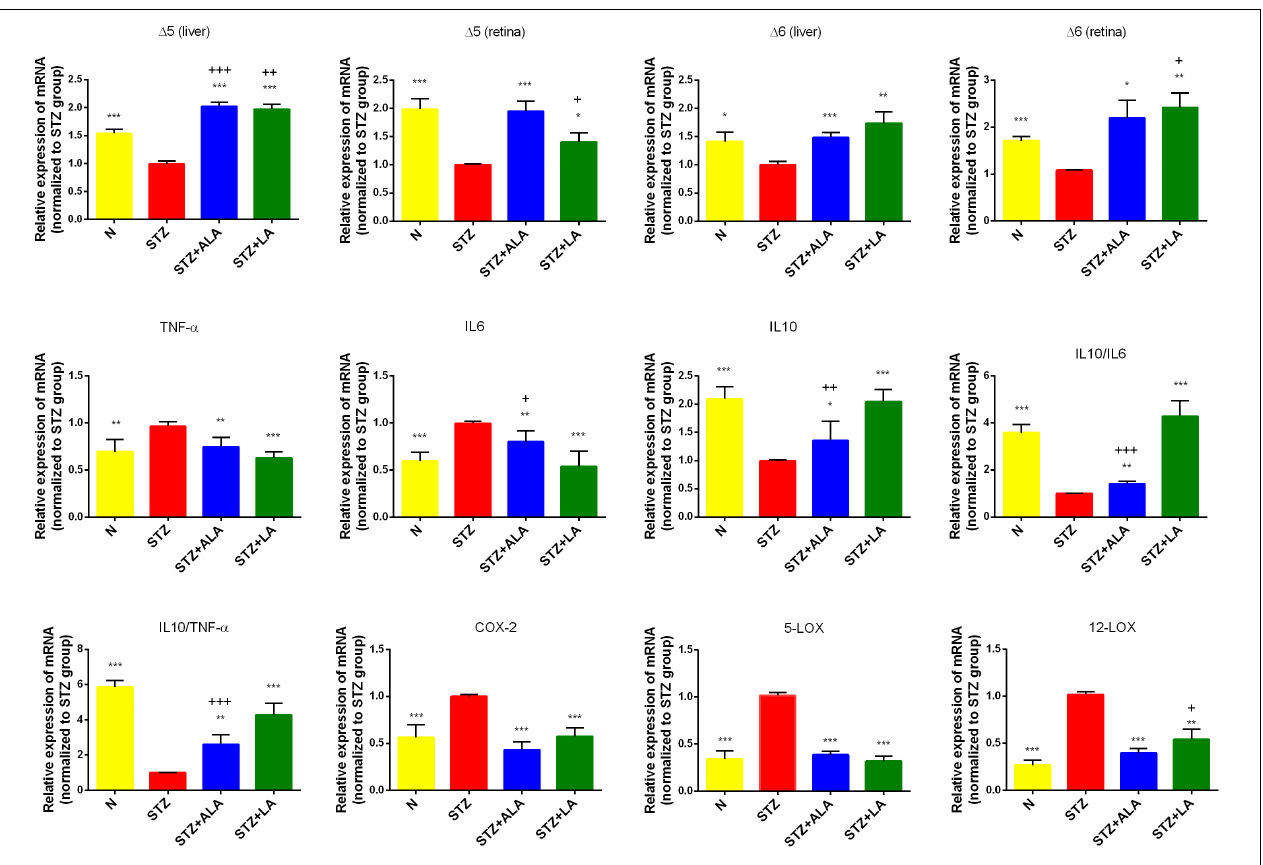
FIGURE 4 | (cid:49) 5 desaturase, (cid:49) 6 desaturase (in both retina and liver), inflammatory cytokines, COX-2, 5-LOX, and 12-LOX expressions (in the retina only) of the experimental animals. All values are expressed as mean ± SEM ( n = 5). Comparisons were performed using one-way ANOVA with Tukey’s post-hoc test.* vs. the STZ-treated group. * p ≤ 0.05, ** p ≤ 0.01, *** p ≤ 0.001. + vs. the normal control group. + p ≤ 0.05, ++ p ≤ 0.01, +++ p ≤